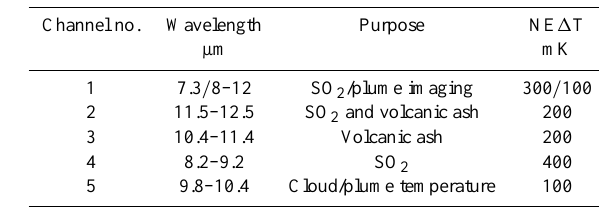
Table 1. Channel number, central wavelength, bandwidth, purpose and required noise-equivalent temperature difference (NE 1T ) for